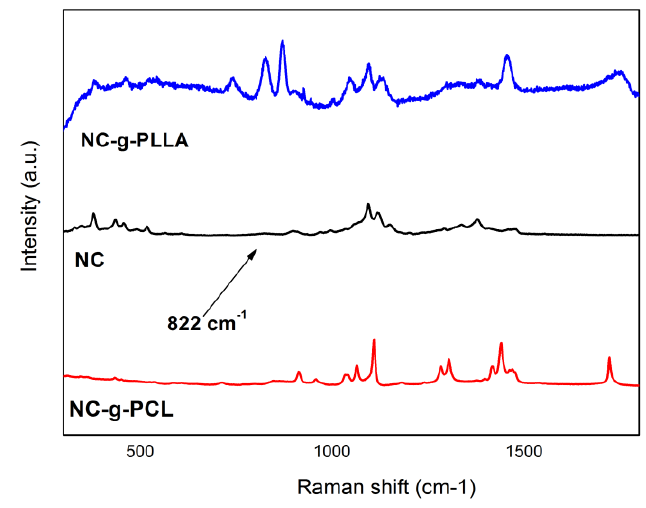
Figure 6. Raman spectra for: neat cellulose NC, NC-g-PCL, and NC-g-PLLA. In Figure 5a,b, the spectra for the functionalized NC obtained by grafting PCL and PLLA, respectively, onto the external surface of the cellulose nanocrystals are shown. The presence of characteristic peaks is evident for both the NC and the polymeric chain. For PCL, in the inset of Figure 4a, the range 3000–4000 cm − 1 is magnified to appreciate its peaks. The characteristic stretching band for hydroxyl groups in the region of 3000 to 3600 cm − 1 can be observed in both cellulose-grafted NC spectra. In fact, the broad peak of hydroxyl groups of cellulose NC from 3200 to 3600 cm − 1 and the presence of the sharper absorption of the carboxyl group of PCL at 1721 cm − 1 reflect the presence of both components in the NC-g-PCL sample (Figure 5a). Similarly, the band of the PLLA carbonyl group at 1753 cm − 1 was found in the NC-g-PLLA spectrum (Figure